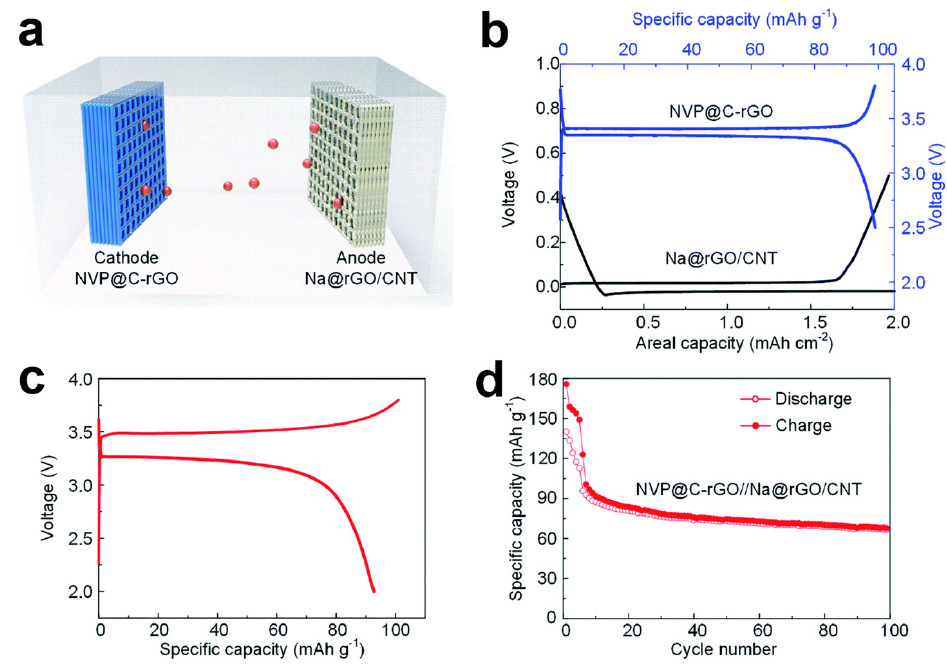
Figure 9. ( a ) Structure diagram of SIBs composite of cathode (NVP@C-rGO) and anode (Na@rGO/CNT); ( b ) GCD curves of the cathode (NVP@C-rGO, blue lines) and anode (Na@rGO/CNT, dark lines) half cells; ( c ) GCD curves of Na@rGO/CNT//NVP@C-rGO battery at 100 mA g − 1 ; ( d ) The specific capacity change with the cycle number at the current density of 100 mA g − 1 . Reproduced with permission [47]. Copyright 2020, Royal Society of Chemistry.